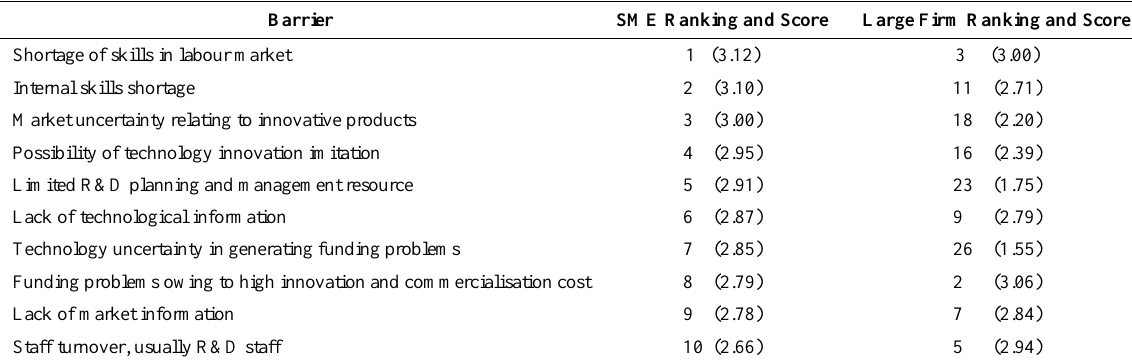
Table 4. Barriers to Innovation in Large Firms and SMEs